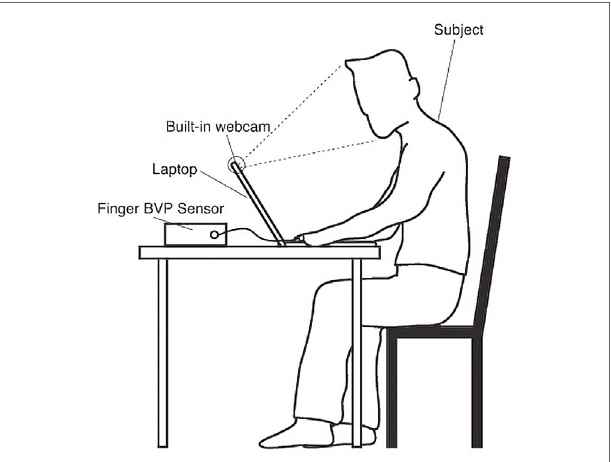
FigURe 3 | Experimental setup (Poh et al.,